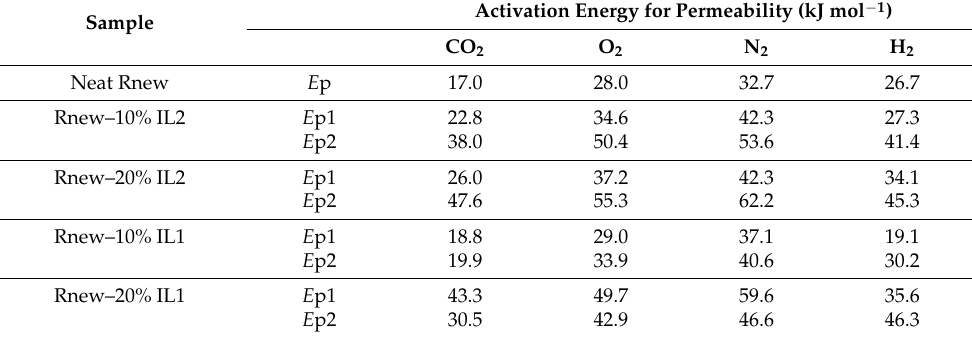
Table 4. Apparent activation energy for permeation ( E p), evaluated in the temperature range of 15– 55 °C, for Pebax ® Rnew films and representative Pebax/ILs samples. E p1 below the IL T m; E p2 above the IL T m.